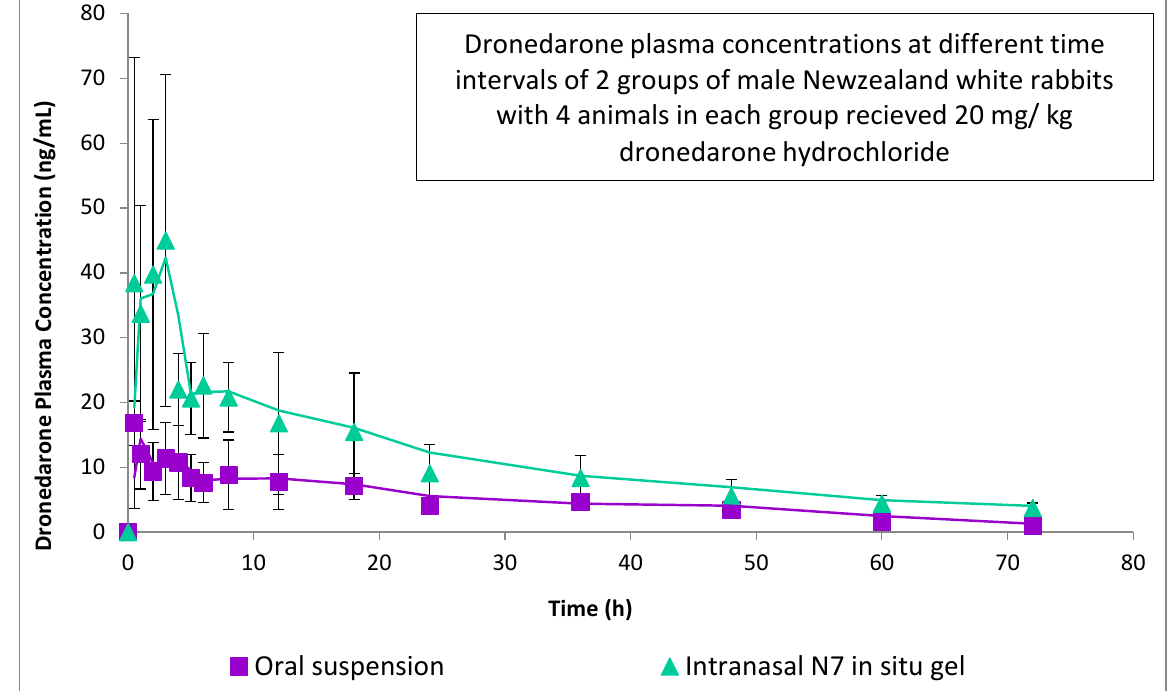
Figure 6. Plasma concentration-time curve of dronedarone after administration of intranasal N7 in situ gel and DRN oral suspension to experimental rabbits.